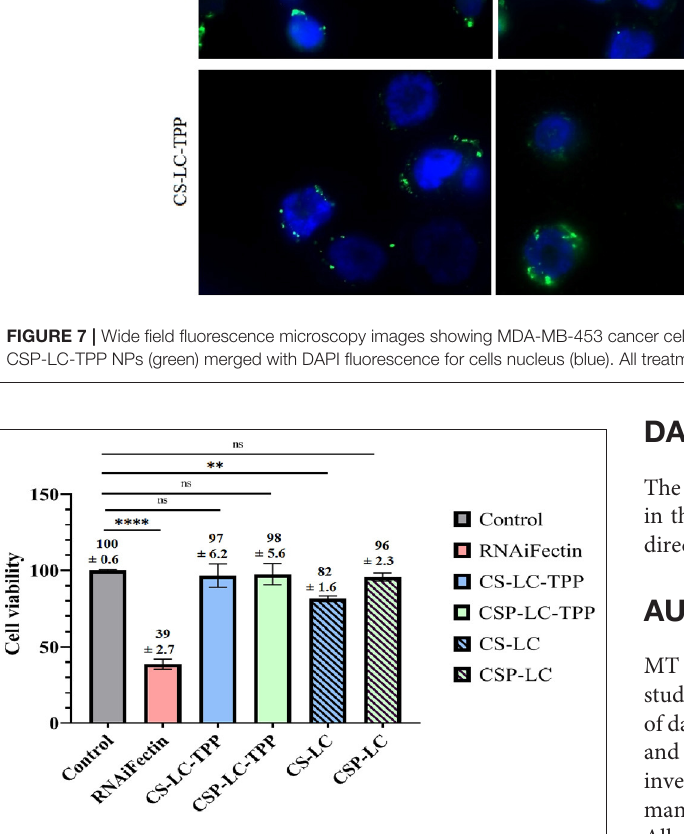
FIGURE 8 | Histogram showing the percentage of MDA-MB-453 cancer cell viability upon exposure to NPs and RNAifectin. ns: no significant difference, **significant difference at P < 0.005, ****significant difference at P < 0.0001. Untreated cells used as